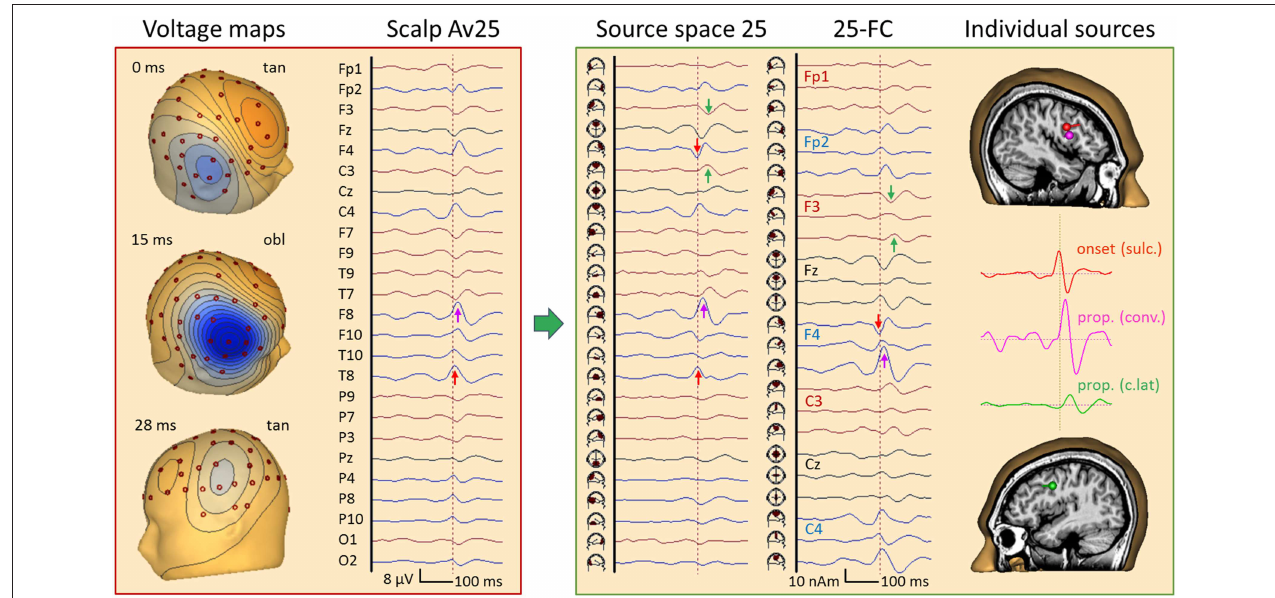
FIGURE 12 | Right frontal propagating IED, 84 averages, EEG results. Filtering: 5Hz forward to 40Hz to reveal IED onset (26). In the virtual average-reference montage Av25 ( 26), the earliest IED peak is seen at T8 (red arrow) followed by F8 (pink). In source space 25, the peak below T8 appears earlier (0ms) and synchronous with a peak of opposite polarity under F4, indicating an origin between the 2 regions. The corresponding onset map appears tangential, followed by an oblique map with a strong surface negative peak at 15ms near F8 (pink arrow) and another near-to-tangential map over the left frontal cortex at 26ms. The left frontal IED appears below F3 and C3 (green) in source space 25. When inspecting all frontal-central channels of source space 25 (25-FC), the strongest peak (15ms) is seen in the 2nd tangential trace of the regional source below F4 while the earlier onset is seen in the 1st trace. The individual source model needed 3 dipoles to separate the sulcal onset (red, peak at 0ms) from the larger peak activity (pink, 15ms) in the same frontal-central region on the right. The 3rd source waveform (green, 26ms) isolated the IED propagated to the